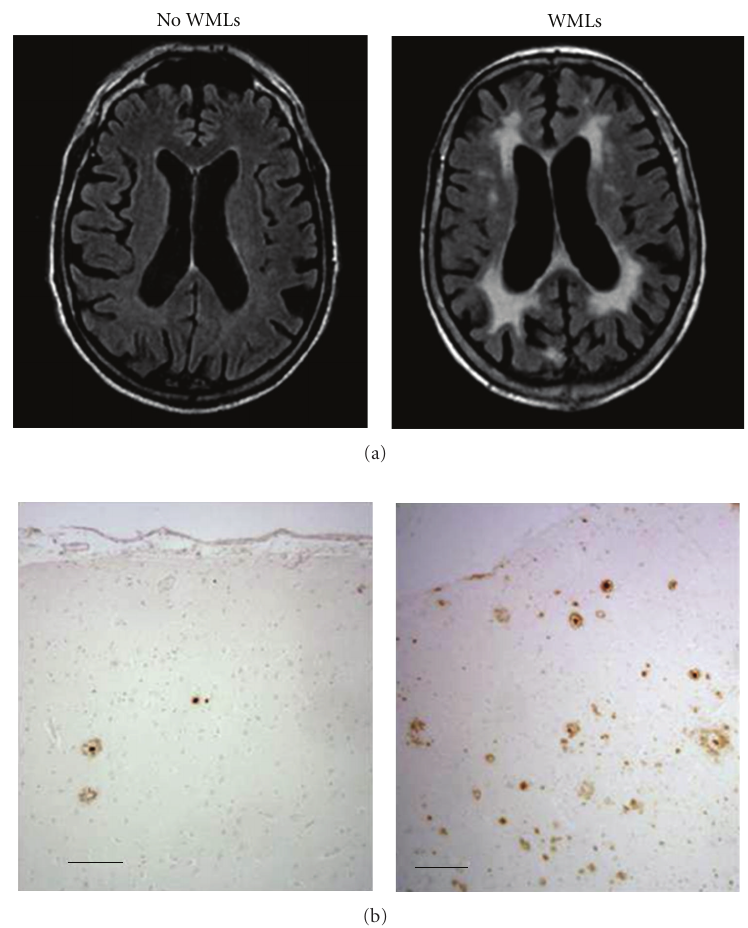
Figure 1: (a) MRI scans with and without white matter lesions and (b) corresponding β -amyloid pathology in the cortex. Bar = 100 μ m.